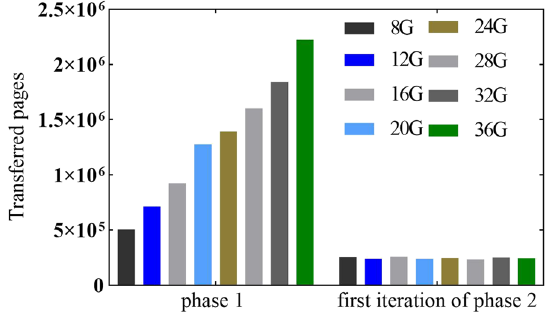
Fig. 6 Number of memory pages transferred in phase 1 and the first iteration of phase 2 when migrating a VM running lmbench for different memory size VMs